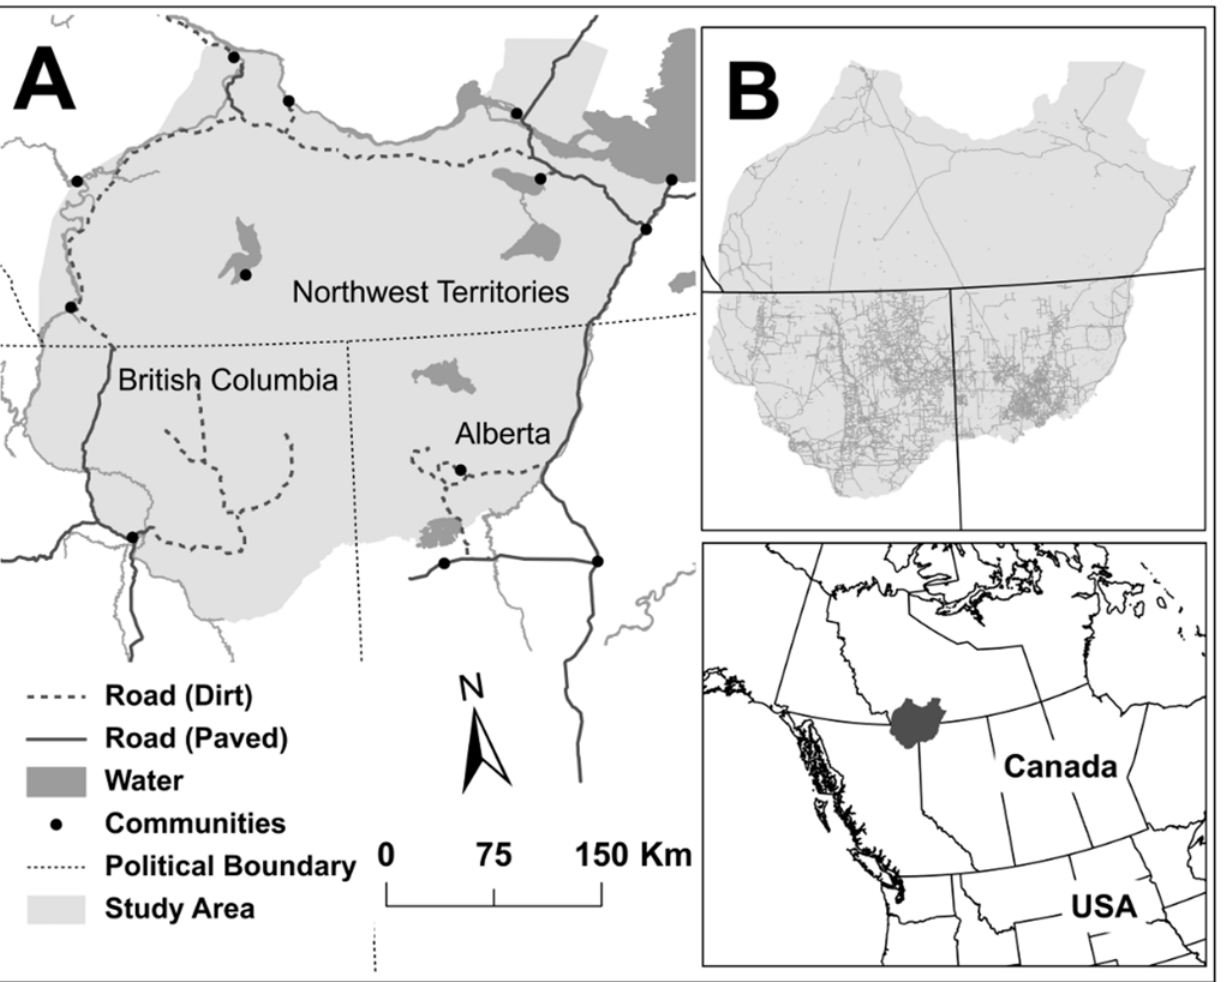
Fig 1. Study area. The study area in northeast Alberta, northwest British Columbia, and southwest Northwest Territories (A). Territorial and Provincial jurisdictions in western Canada are subject to divergent energy policies as evident from the extent of the disturbance footprint (shown in light grey, but excluding seismic lines for clarity)